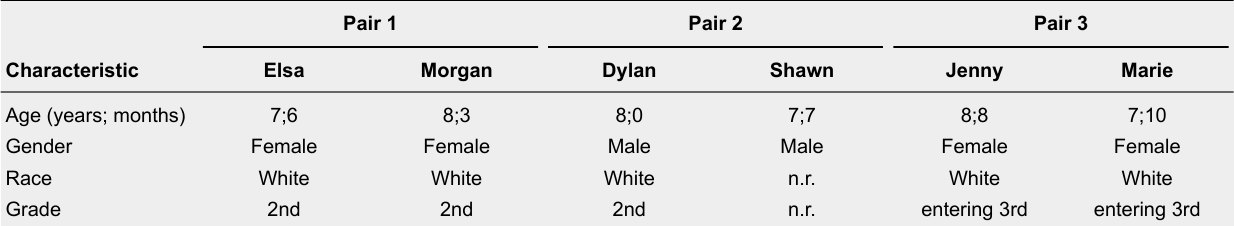
Case Participants’ Demographic